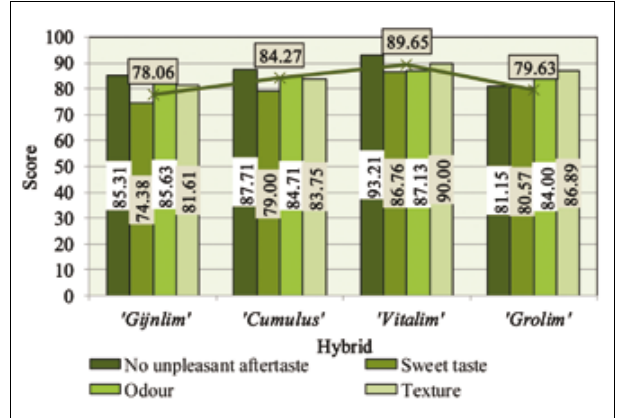
Figure 3. Connection between total impression – aftertaste, sweetness, odour and texture